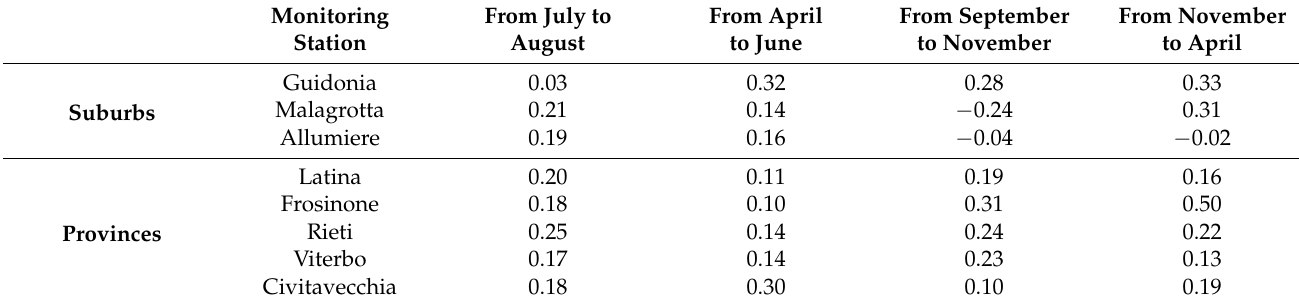
Table 10. Cross-correlation values between Roma Green Band and suburbs or province stations of [SO 2 ] in 2015. Monitoring